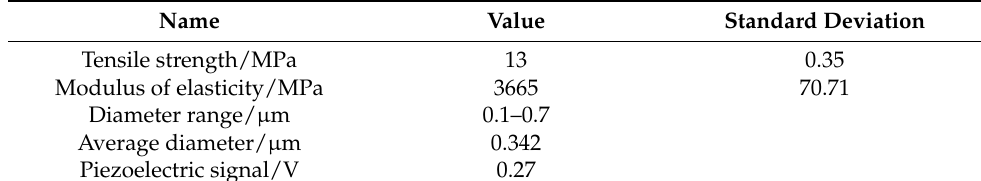
Figure 6. SEM image of the pure PVDF fiber membrane: ( a ) 2000 magnification; ( b ) 5000 magnification. Table 2. Tensile strength, modulus of elasticity, average diameter, and diameter range of P-PVDF.